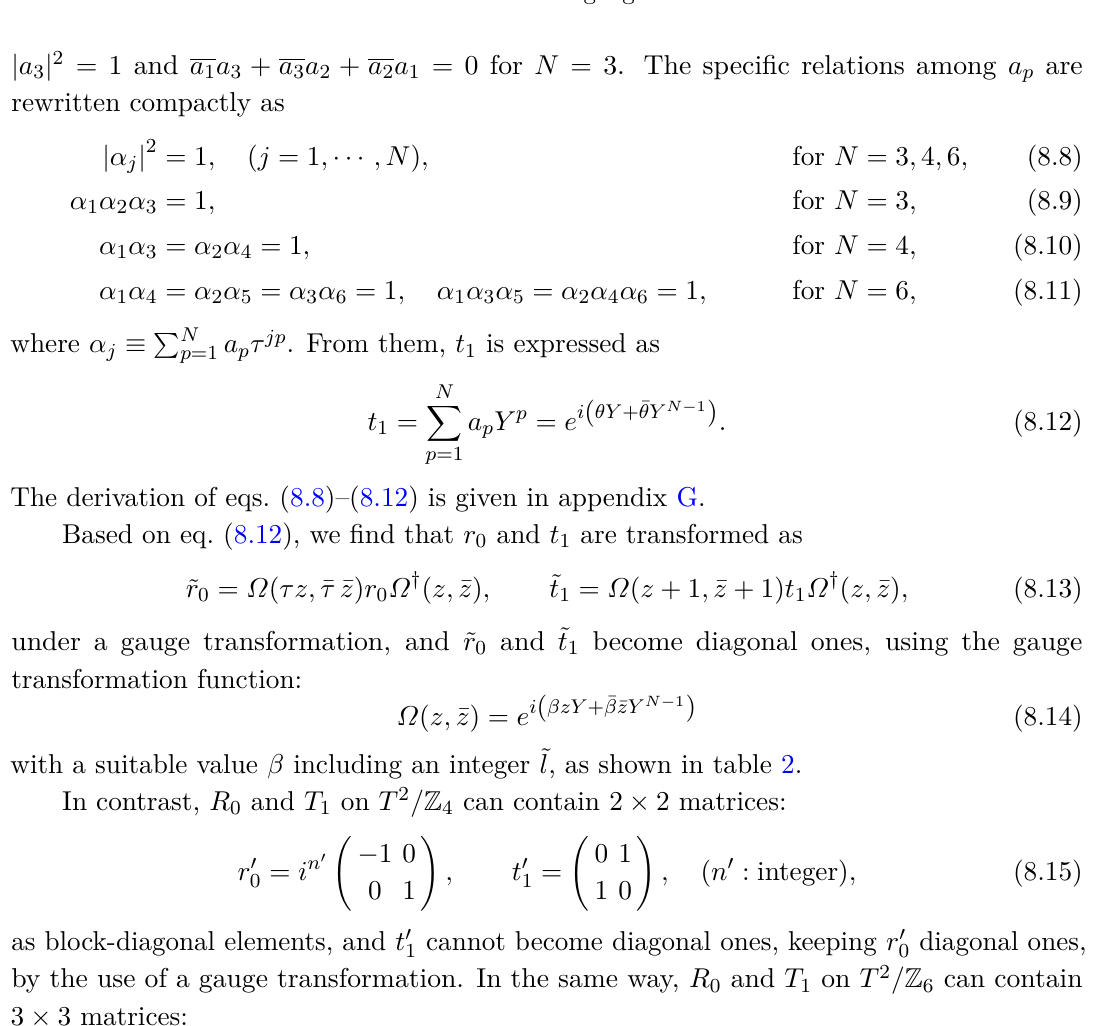
Table 2 . Peculiar constraints and gauge transformed